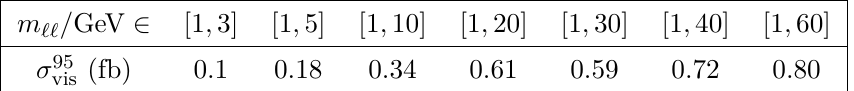
Table 4 . Signal regions in the ATLAS soft-dilepton + jets + /E denotes the observed 95% C.L. upper limit on the visible cross section σ vis